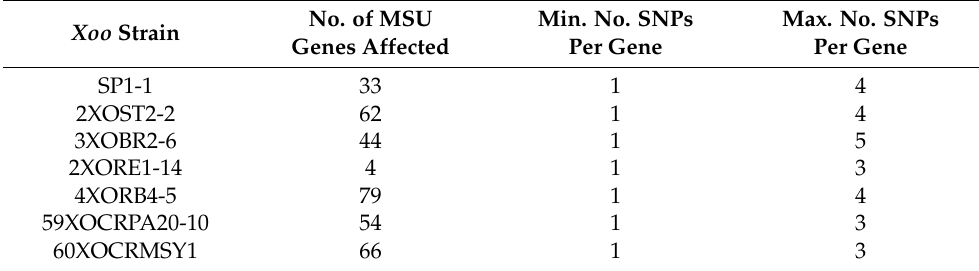
Table 4. Summary table of MSU designated gene regions containing significantly associated SNPs according to Xoo strain inoculation. No. of